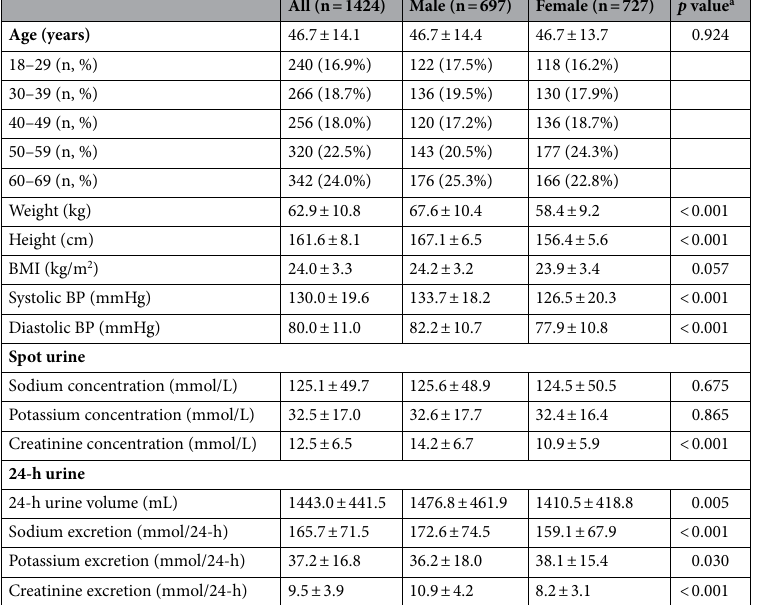
Table 2. Characteristics of the 1424 participants according to gender. a Differences between males and females were tested by independent samples